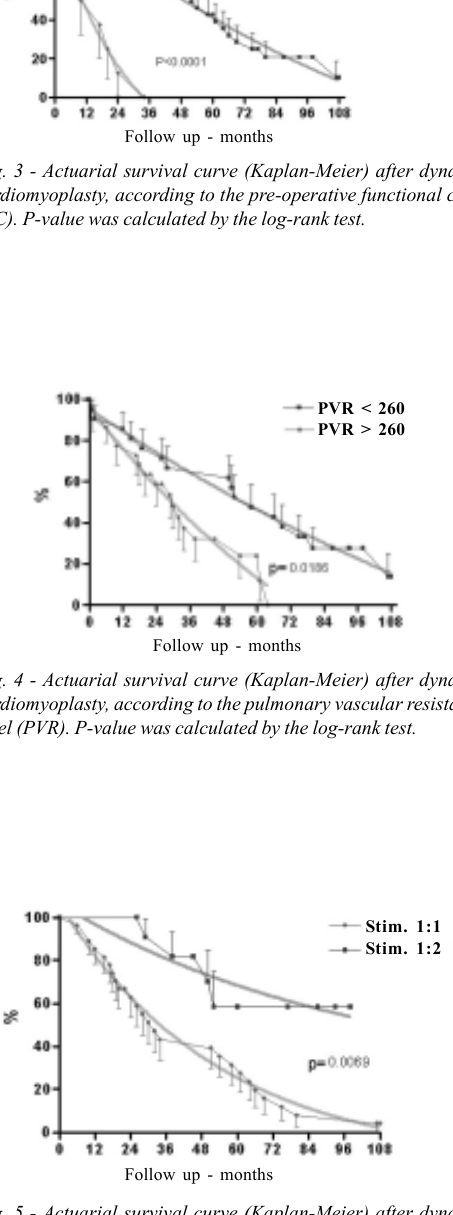
Fig. 5 - Actuarial survival curve (Kaplan-Meier) after dynamic cardiomyoplasty, according to the stimulation mode. P-value was calculated by the log-rank test.